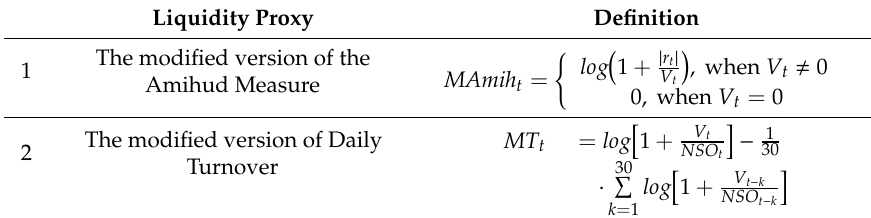
Table 2. Definition of liquidity estimates derived from low-frequency daily